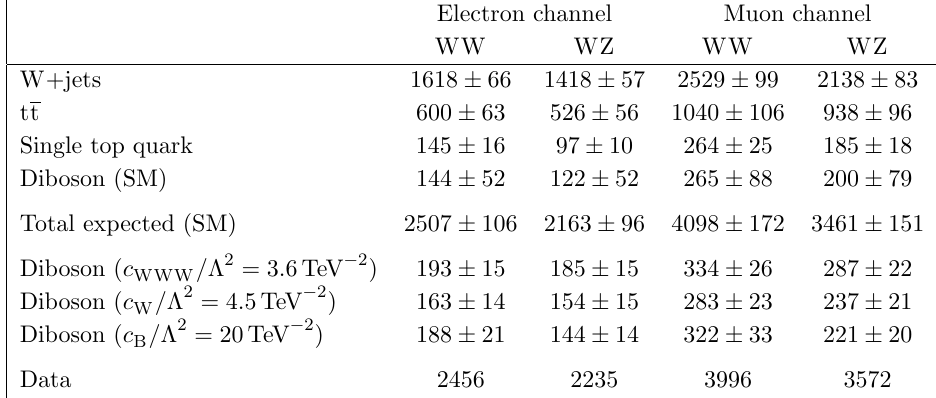
Table 3 . Summary of background, signal, and data yields in the WW and WZ categories for each lepton channel. Uncertainties in the background contributions are described in section 7. The diboson signal predictions with anomalous couplings include both standard model and anomalous contributions, as well as the relevant interference terms.